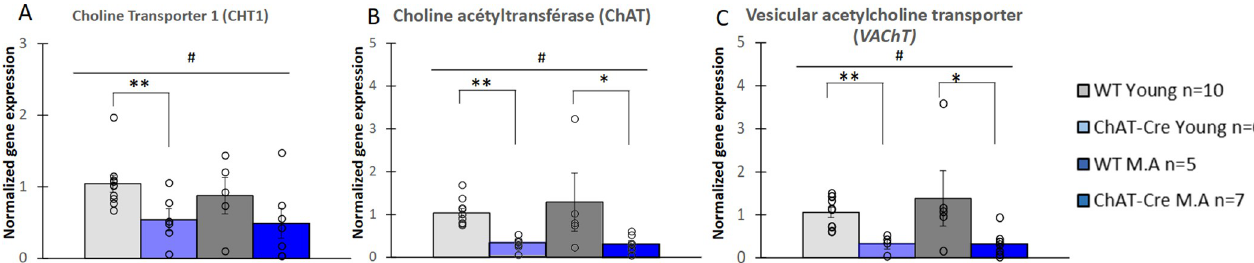
Fig 8. Analysis of CHT , ChAT and VAChT gene expression in the dorsal striatum. Quantification of CHT-mRNAs (A), ChAT-mRNAs (B) and VAChT- mRNAs (C) by RT-qPCR. mRNA levels are presented relative to the young WT group. WT young n = 10, ChAT-Cre young n = 6, WT Middle Age (M.A.) n = 5, ChAT-Cre Middle Age n = 7. Data are presented as means ± SE; � p < 0.05; �� p < 0.01; ��� p < 0.001; Kruskal-Wallis rank-sum test analysis then Wilcoxon and d signed-rank tests were applied when appropriate. # represents the genotype effect and ◆ the age effect. Kruskal-Wallis results were not represented for